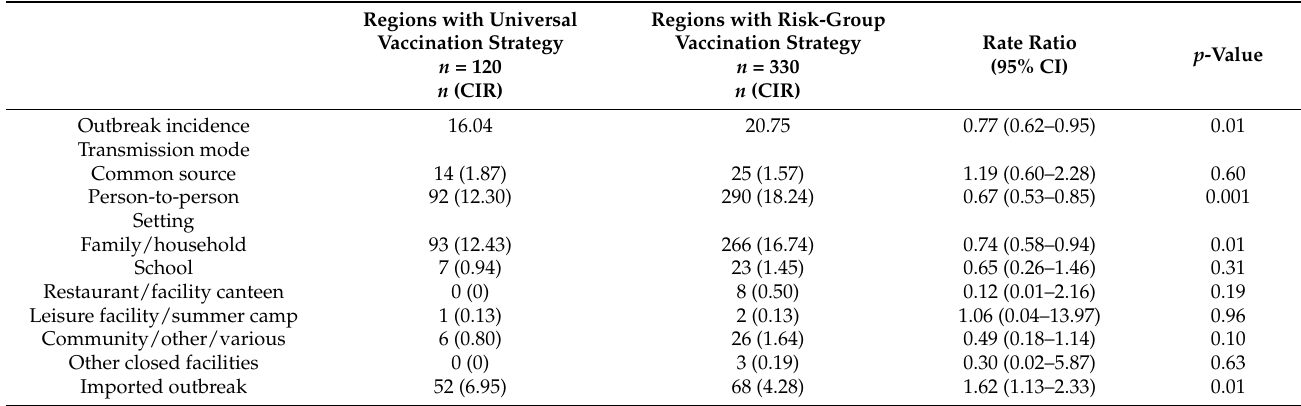
Table 1. Number and cumulative incidence rate per million inhabitants of hepatitis A in regions with different vaccination strategies. Spain,